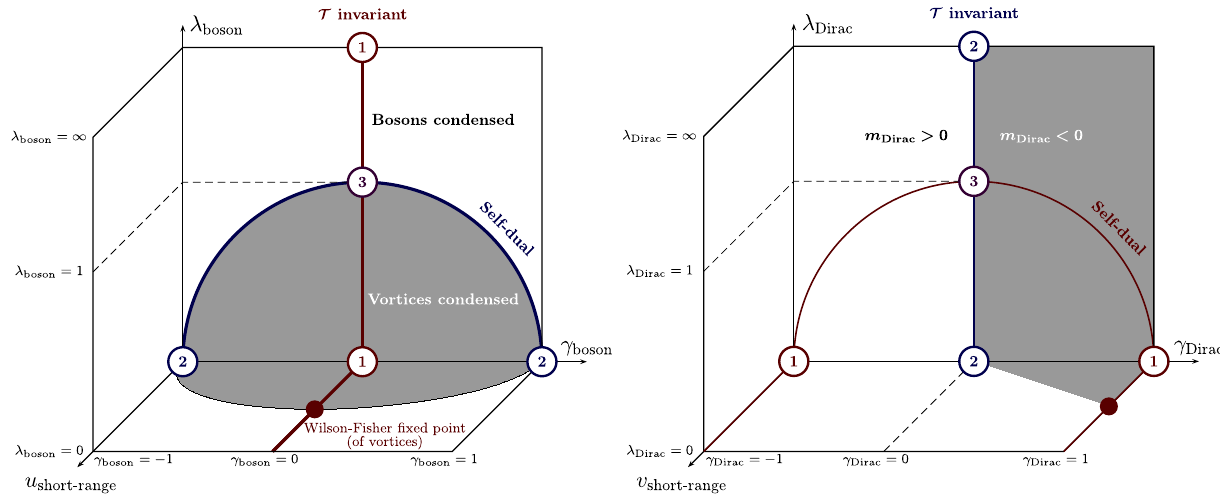
FIG. 3. Left panel: Phase diagram of bosons with Chern-Simons term ( γ ), marginally long-range interactions ( λ ), and additional boson boson 0 . When additionally λ 0 , the nonuniversal short-range interactions ( u ). Time-reversal symmetry is present at γ short-range boson ¼ boson ¼ bosons interact via a gauge field that obeys Maxwell dynamics. This corresponds to vortices with purely short-range interactions, which may either condense or become gapped. The transition between the two phases is governed by the Wilson-Fisher fixed point. In contrast, γ 0 and λ ∞ formally corresponds to bosons with purely short-range interactions. These two limits are related by the boson ¼ boson ¼ 1 , standard boson-vortex duality of Eq. (1). Finite, nonzero λ interpolates between the two with self-duality realized at λ boson boson ¼ corresponding to Eq. (3). This point describes a quantum phase transition between the same phases as the Wilson-Fisher fixed point (either bosons or vortices condense) but is of a different universality class because of the marginally long-range interactions (strictly speaking, long-distance properties of the two phases also change qualitatively for finite nonzero λ ). For nonzero γ , this point extends into a bos bosons self-dual line of phase transitions at λ 2 þ γ 2 ¼ 1 ; this includes the case of bosons with purely statistical interactions described by bosons bosons 0 plane, which is something we can Eq. (2). In the figure, we assumed that this line of self-dual phase transitions lies in the u short-range ¼ realize in explicit wire models. Right panel: The same models can be transcribed into Dirac fermions with statistical ( γ ), marginally Dirac long-range ( λ ), and additional short-range interactions ( v ). The self-dual line of bosons maps onto time-reversal-invariant Dirac short-range 0 , which are critical. It separates gapped phases with opposite sign of the Dirac mass m fermions γ , which corresponds to either Dirac ¼ Dirac 0 line includes the special cases of N ¼ 1 QED λ 0 ), Dirac fermions with short-range bosons or vortices condensing. The γ 3 ( Dirac ¼ Dirac ¼ ∞ ), and self-dual Dirac fermions ( λ 1 ). As for the case of bosons, the self-dual point extends to a self-dual line interactions ( λ Dirac ¼ Dirac ¼ ≠ 0 . It includes the case of Dirac fermions with purely statistical interactions, λ 0 and γ 1 , which is self-dual and for for γ Dirac Dirac ¼ Dirac ¼ which short-range interactions v can drive a phase transition in the Wilson-Fisher universality short-range